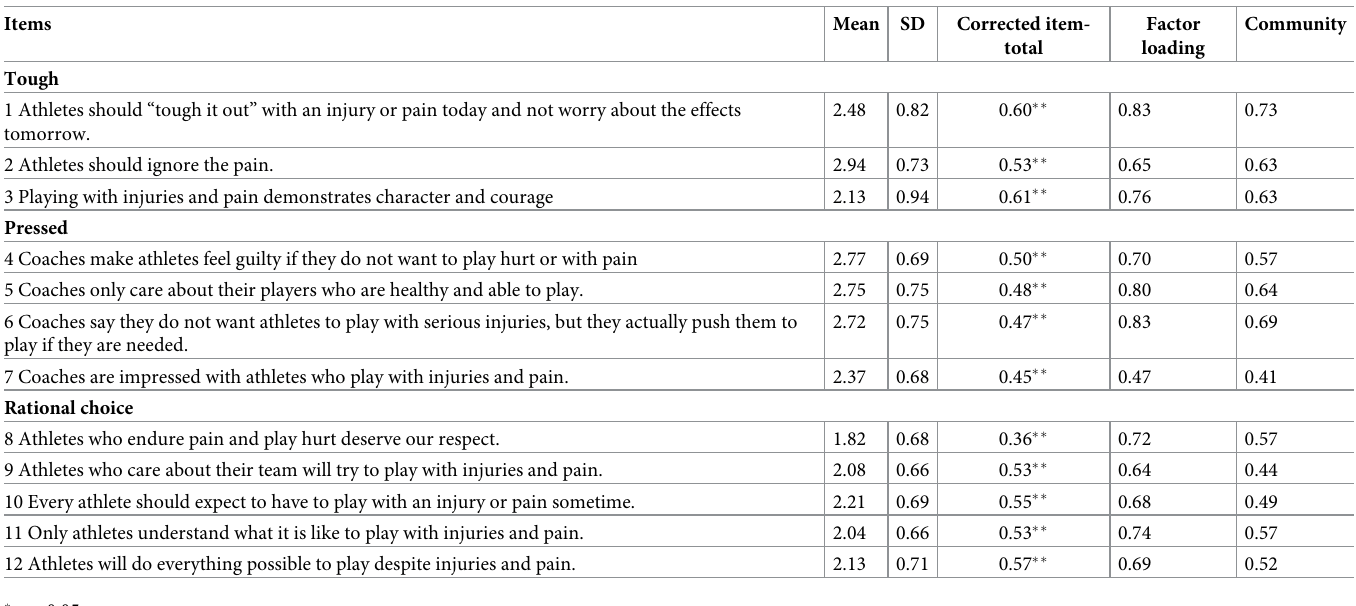
Table 2. Descriptive statistics of RPIQ